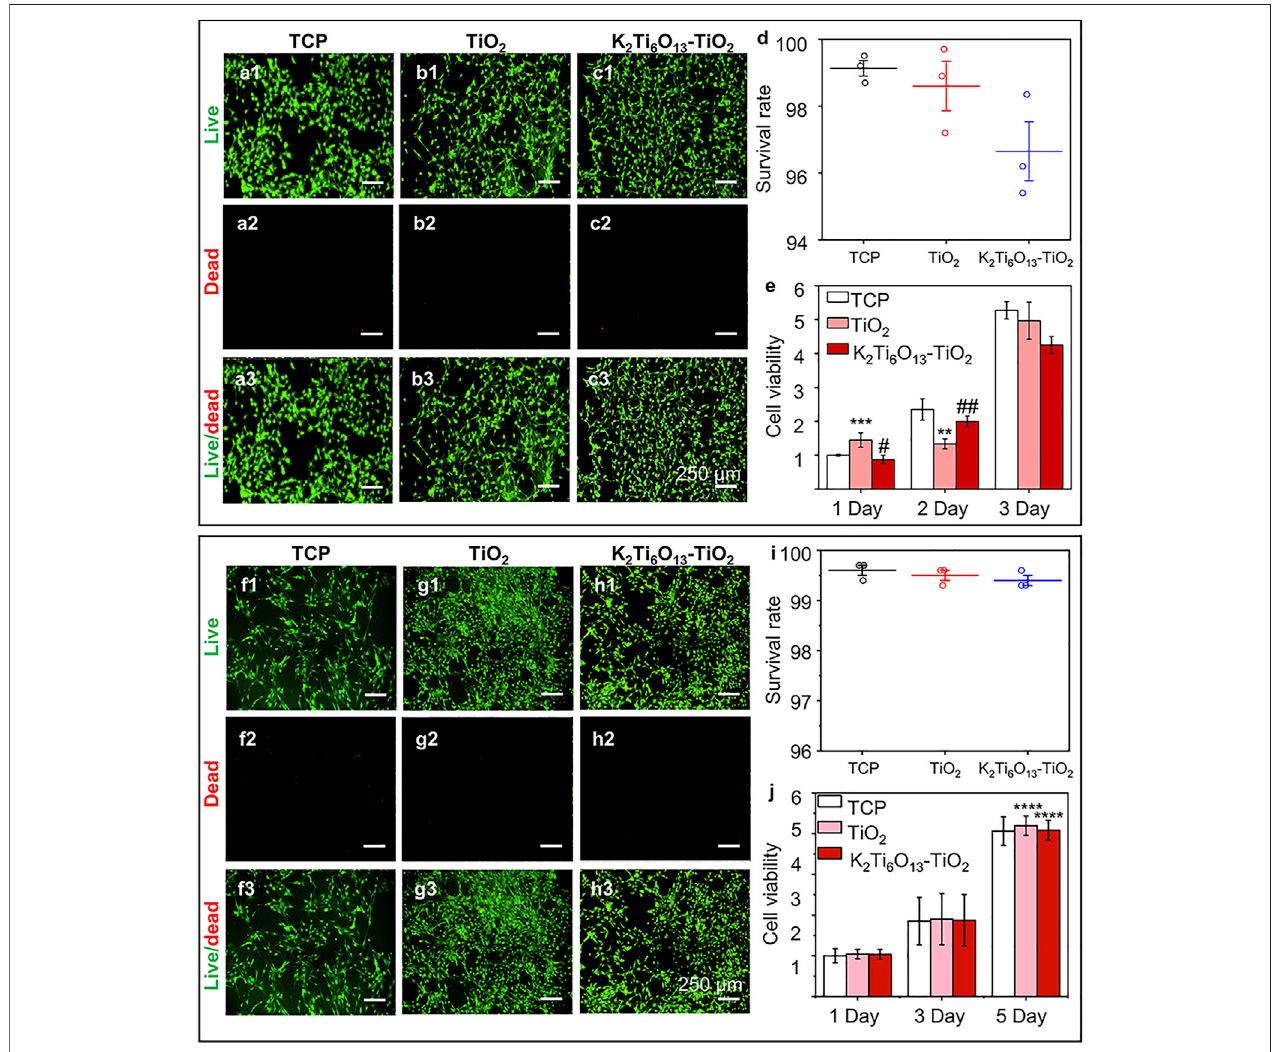
FIGURE 3 | Cell viability of NSCs and MSCs cultured on different substrates., (A – C) Live/dead cellular staining images of NSCs seeded on the (A) tissue culture plate, (B) TiO 2 nanotube array, and (C) K 2 Ti 6 O 13 -TiO 2 hybrid nanorod array for 48 h, respectively. Live cells were stained green and dead cells were stained red. (D) Survival rate ofNSCs on three substrates for 48 h. (E) Cell viability of cultured NSCs at 1, 2, and 3 d (F – H) Live/dead cellular stainingimagesof MSCs seeded on the (F) tissue culture plate, (G) TiO 2 nanotube array, and (H) K 2 Ti 6 O 13 -TiO 2 hybrid nanorod array for 48 h. (I) Survival rate of MSCs on three substrates for 48 h., (J) Cell viability of cultured MSCs at 1, 3, and 5 days. Data represent the mean ± standard deviation ( n = 3). * p < .05, ** p < .01, *** p < .001 compared with TCP; # p < .05, ### p < .001 compared with TiO 2 array. Scale bars in (A – C) and (F – H) are 250 μ m.